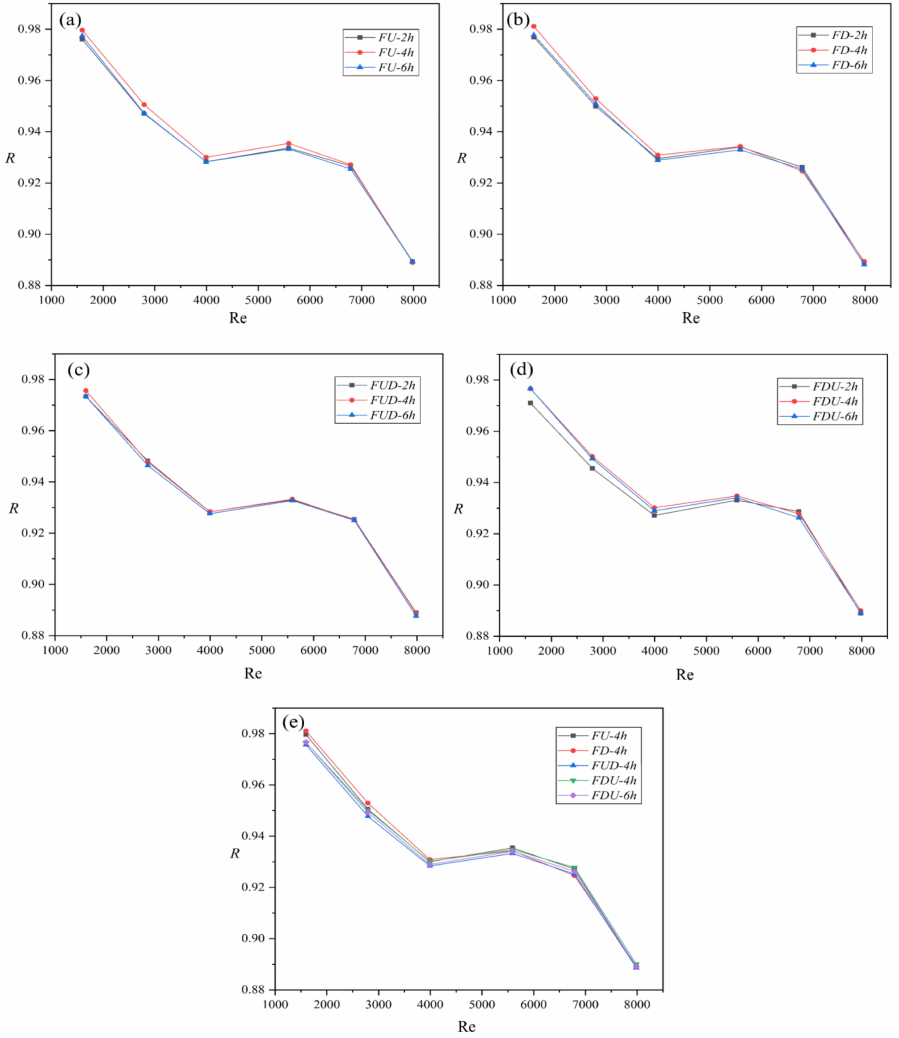
Figure 7. Performance of R at different longitudinal distances (2 h , 4 h , and 6 h ) and distribution modes, ( a ) FU ; ( b ) FD ; ( c ) FUD ; ( d ) FDU and ( e ) relatively better distribution